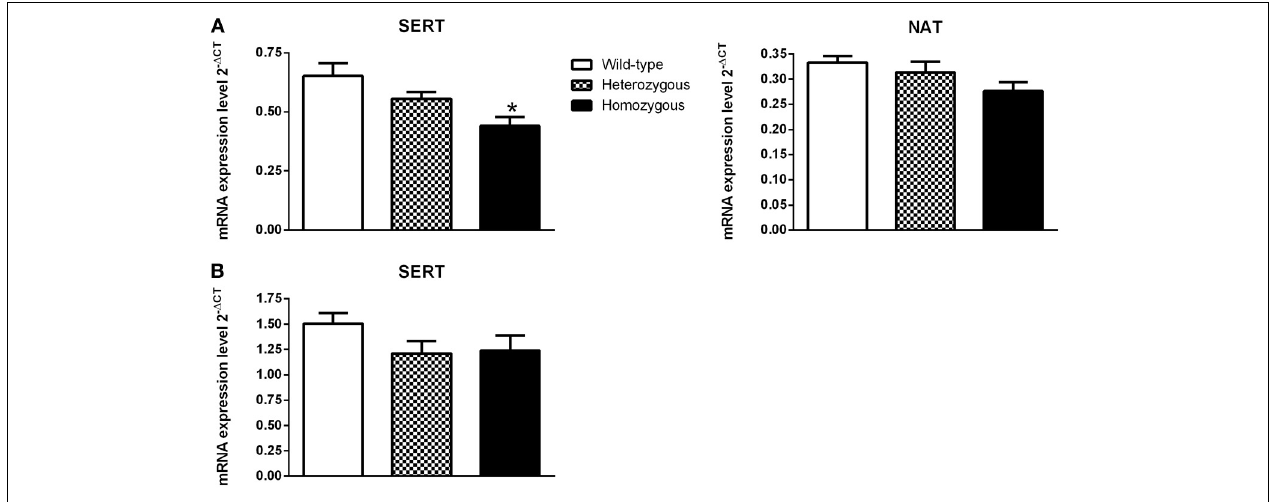
One-WayANOVA).Thenumberofmice in eachgroupwas 12–16.SERT(pons): genotype[ F ( 2 , 41 ) = 6 . 49, p < 0 . 01];NAT (pons):genotype[ F ( 2 , 40 ) = 2 . 57,